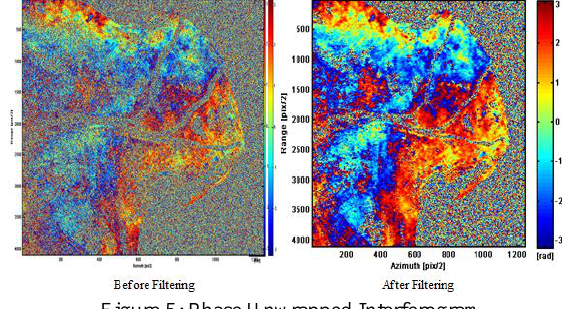
Figure 5: Phase Unwrapped